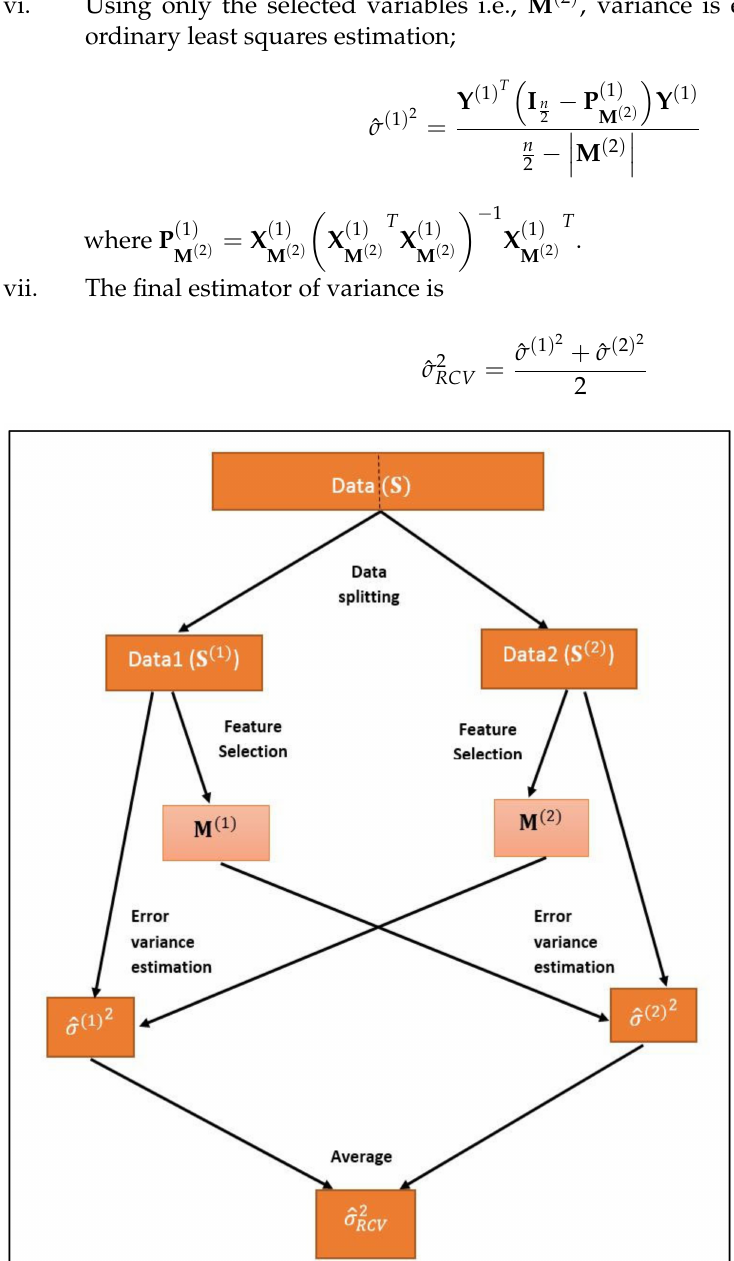
Figure 1. Refitted Cross Validation